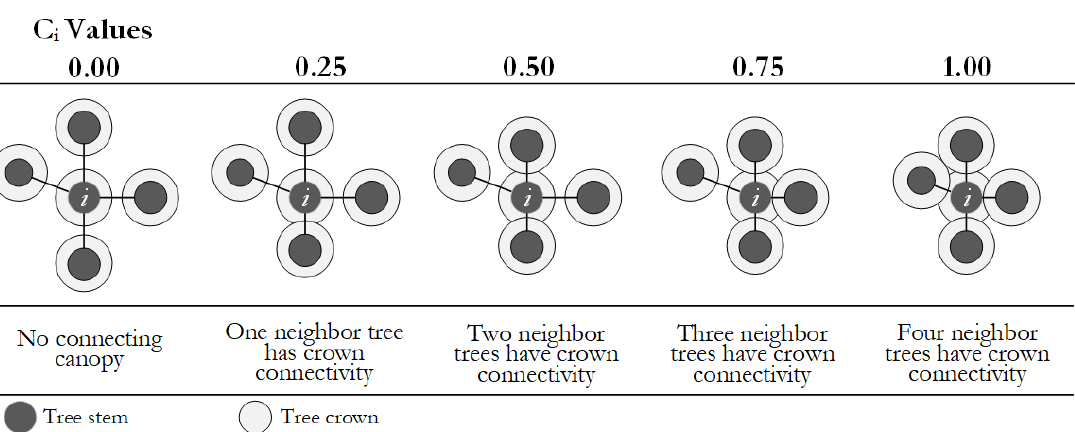
Figure 5. Principle of the crowding degree.